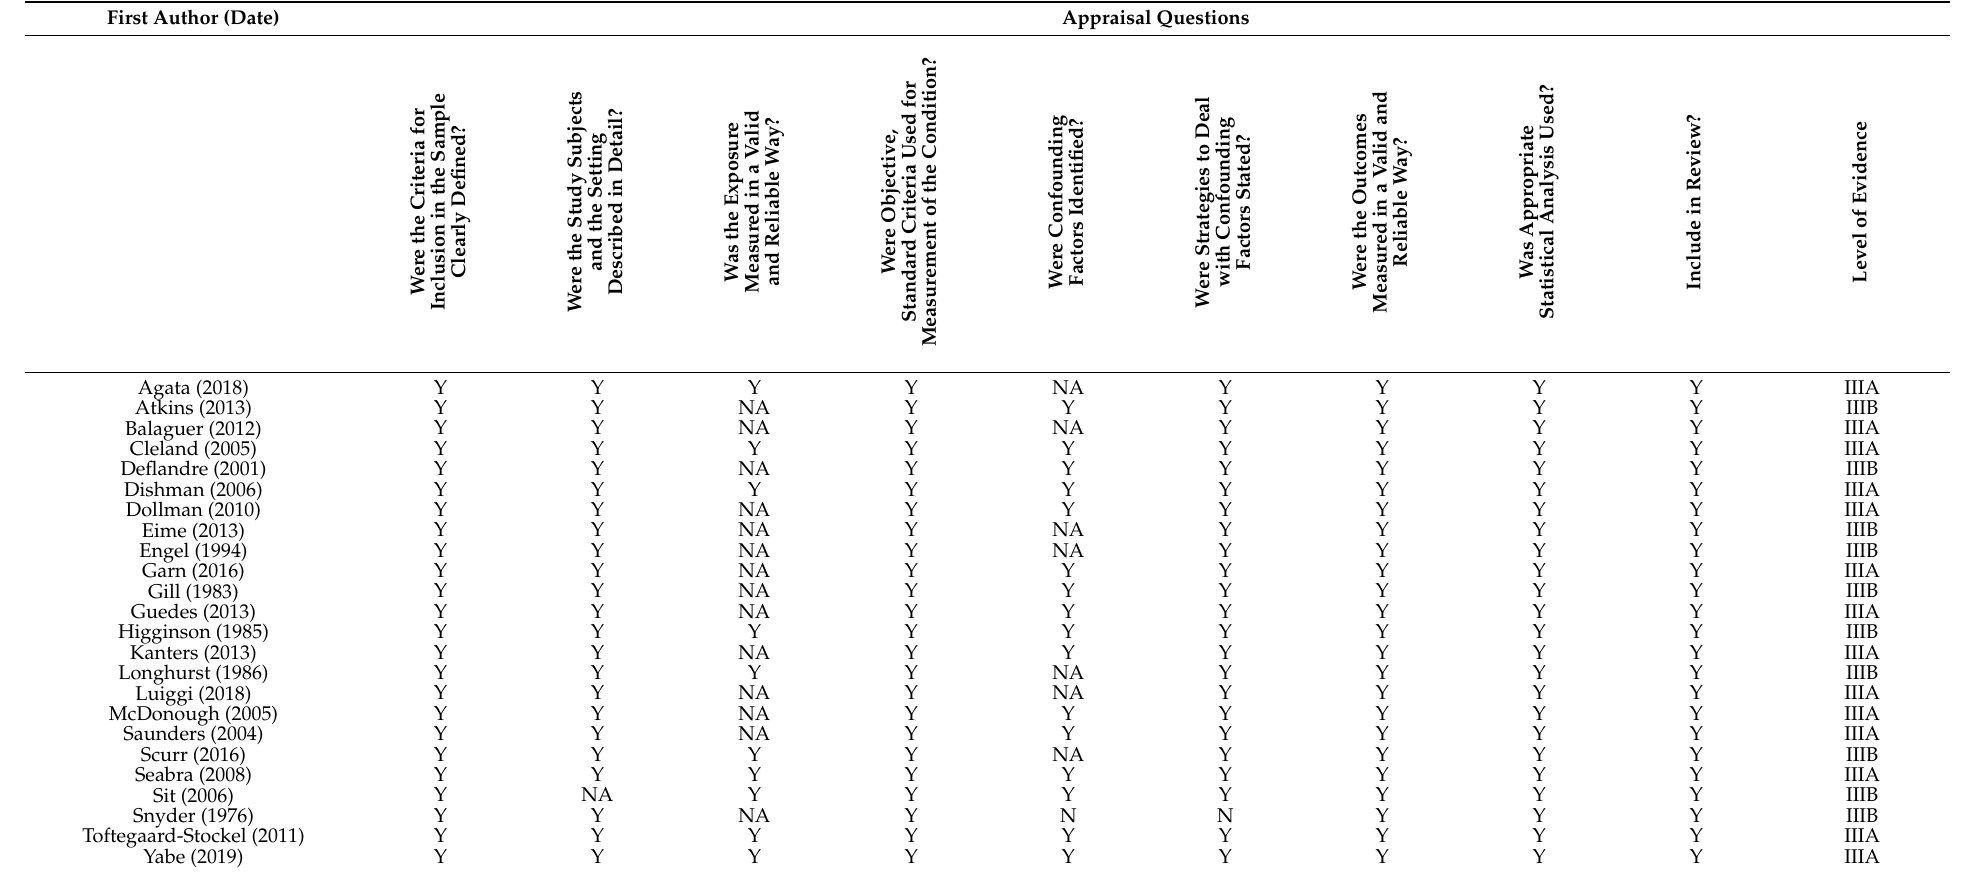
Table A1. Critical appraisal of analytical cross-sectional